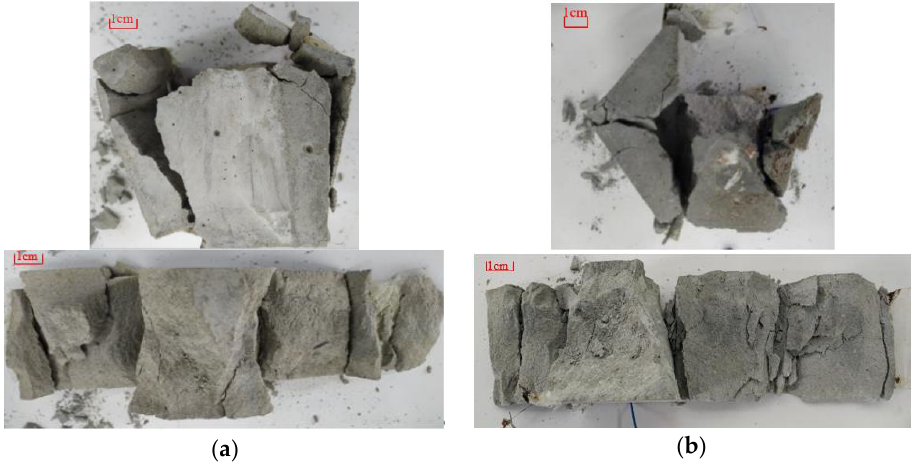
Figure 4. Similar material failure modes. ( a ) Internal failure mode of mudstone-like materials, ( b ) internal failure mode of sandstone-like materials.